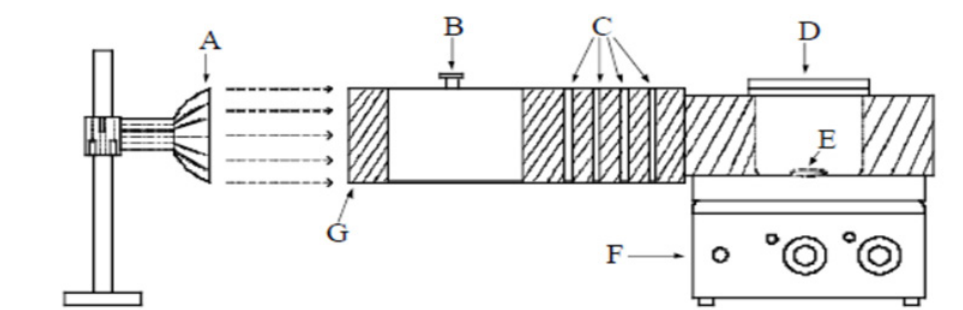
Fig. 2. Schematic representation of photo reactor. (A) light source; (B) UV filters; (C) circulating water (D) beaker with sample solu- tion; (E) magnetic paddle; (F) magnetic stirrer; (G) light